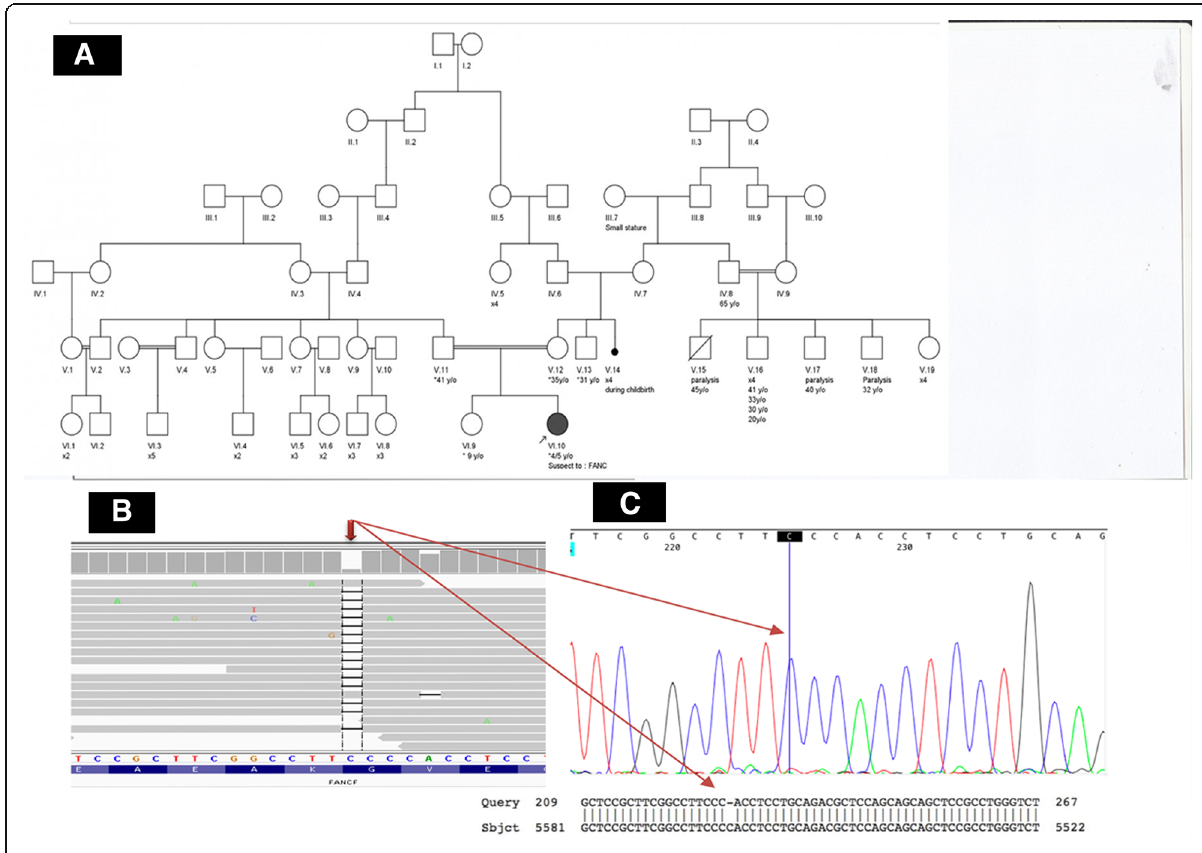
Fig. 2 a : Pedigree, b : NGS data on IGV, and c : Sanger sequencing chromatogram. In the pedigree, proband is shown as a product of consanguineous marriage and the first case affected by FA in this family. Bam file data of the patient show the homozygous deletion (left). Sanger sequencing and NCBI blast confirmed this homozygous deletion